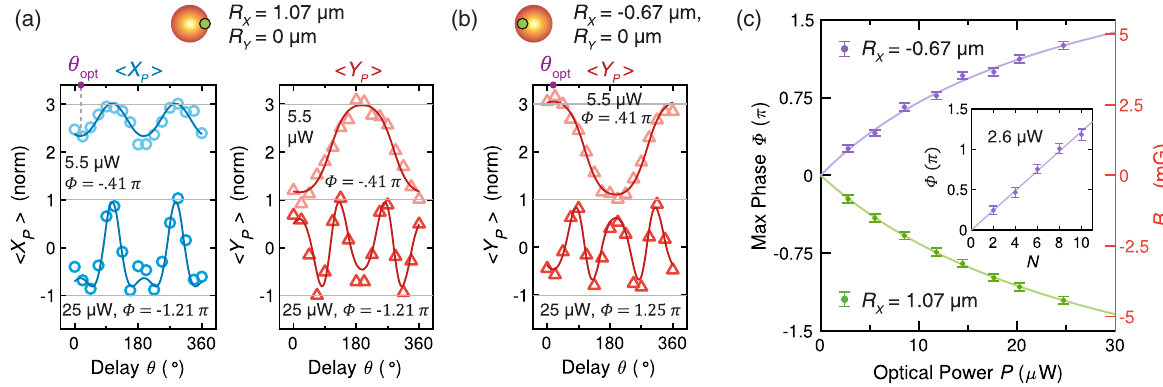
FIG. 3. NV spin precession due to ac magnetic field of local photocurrents. (a) Experimental X P and Y P projections of the final NV superposition state as the delay θ is varied for two different optical powers (synchronized sensing sequence with N ¼ 2 , τ ¼ 7 . 6 μ s). The probe beam ( R X ¼ 1 . 07 μ m) is positioned to the right of the excitation beam over an area where MoS 2 covers the NVensemble. The solid lines are simultaneous fits to both projections, allowing determination of Φ and θ beam ( R X ¼ − 0 . 67 μ m) to the left of the excitation beam. Note that X P (not shown) looks similar to (a), but Y P is inverted, indicating that the local photocurrent direction is reversed. (c) Dependence of the maximum phase Φ on the optical power P for R X ¼ − 0 . 67 μ m (purple) and R X ¼ 1 . 07 μ m (green). The right-hand axis converts Φ to the maximal field amplitude, B photocurrent pulses. Inset: Dependence of Φ on the number of repetitions N of the XY8- N sequence at R X ¼ − 0 . 67 μ m ( τ ¼ 7 . 6 μ s). All error bars presented in this paper are 95% confidence